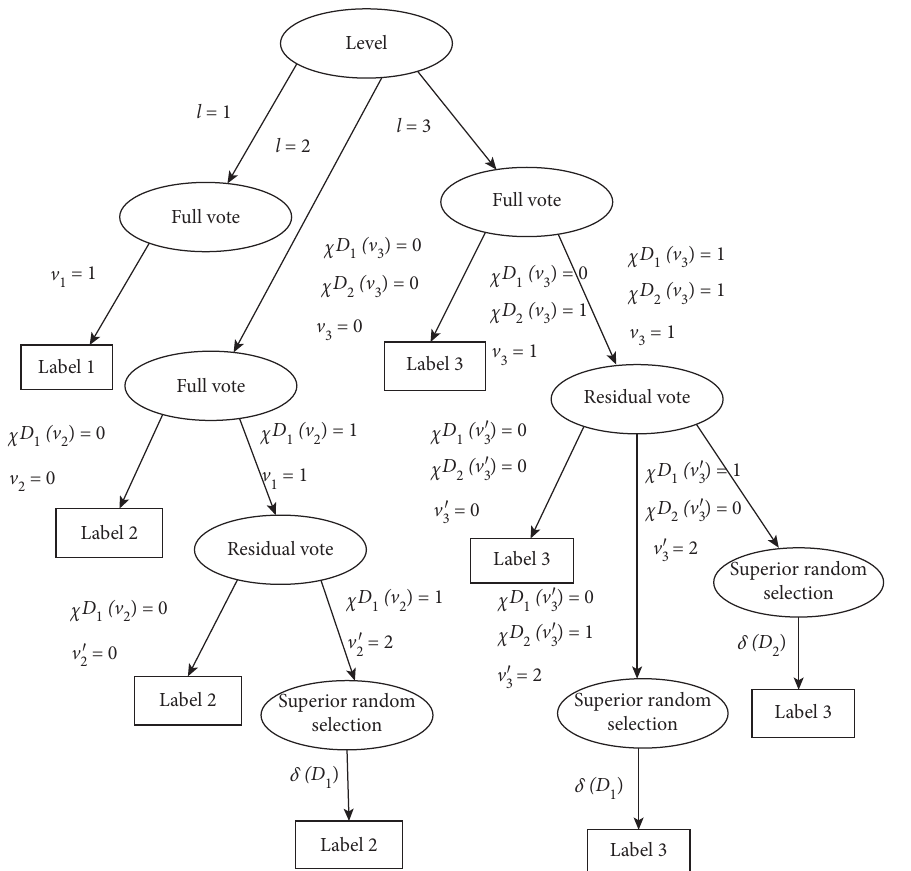
Figure 5: Three-level multitask cooperative voting decision